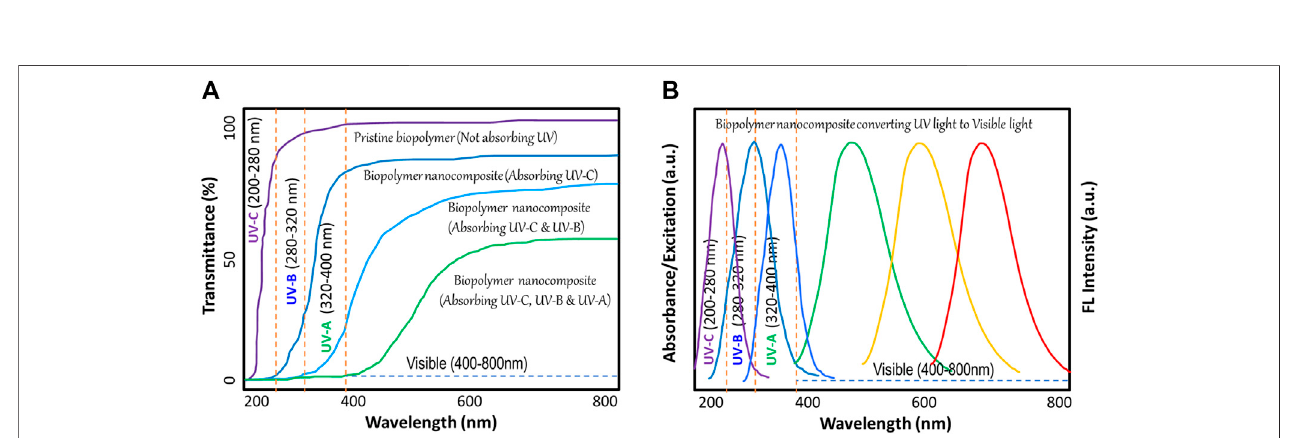
FIGURE 7 | (A) Graphs showing the UV-A, UV-B, and UV-C absorption capacity of pristine biopolymers and biopolymer nanocomposite with respect to % T and (B) spectral pro fi le of UV absorption and simultaneous conversion of absorbed UV light into visible by biopolymer nanocomposite embedded with fl uorescent